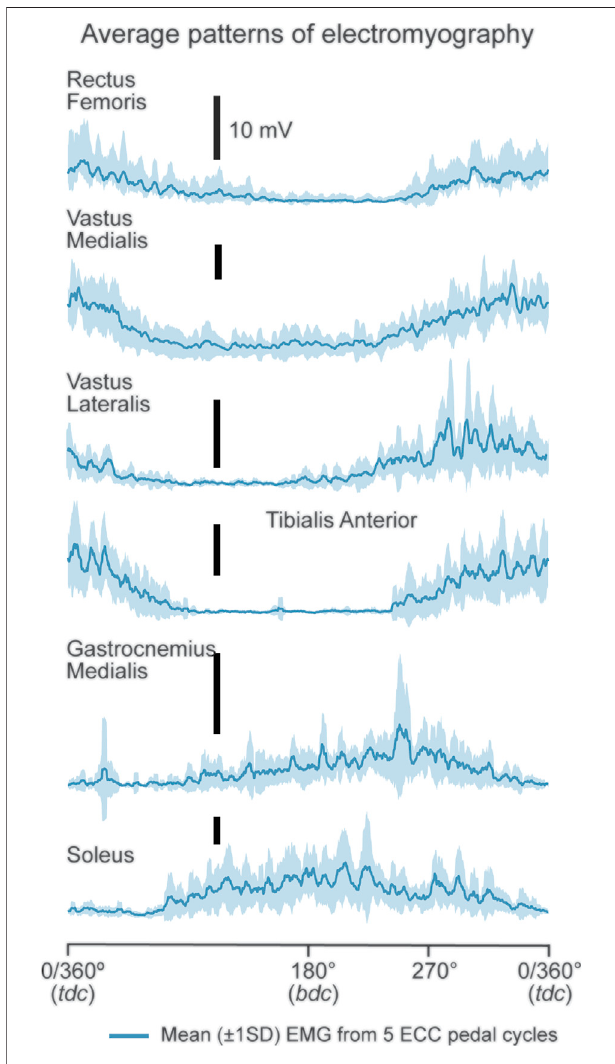
FIGURE 2 | Displayed are mean (±1SD) EMG patterns from RF, VL, VM, TA, GM and SOL for a representative participant. The presented mean RMS EMG tracedatawerebinnedintothefollowing10 stimeseries;(30 – 40[1], 90 – 100 [2], 150 – 160 [3], 210 – 220 [4], 270 – 280 [5], 330 – 340